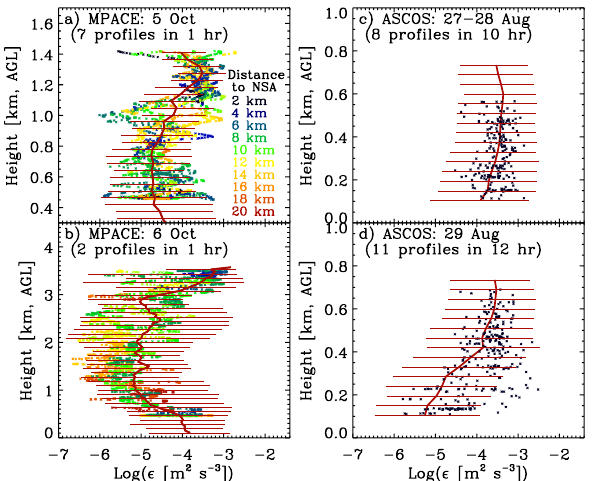
Fig. 5. Vertical profile comparisons of dissipation rate on specific days. In situ observations are given as individual points while radar retrievals are the mean (vertical line) and range (5th to 95th per- centiles as horizontal lines) of values derived over the time pe- riod of the in situ observations. Specific cases include: (a) 19:00– 20:00UTC on 5 October 2004 at MPACE; (b) 19:00–20:00 on 6 October at MPACE; (c) 17:00 on 27 August to 05:00 on 28 Au- gust 2008 at ASCOS; and (d) 00:00–12:00 on 29 August 2008 at ASCOS. For panels (a) and (b) , the horizontal distance from the aircraft measurement to the vertical radar beam is designated by the color of each symbol.